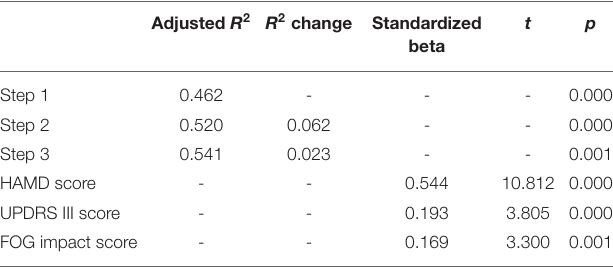
TABLE 3 | A hierarchical regression model of the PDQ-8